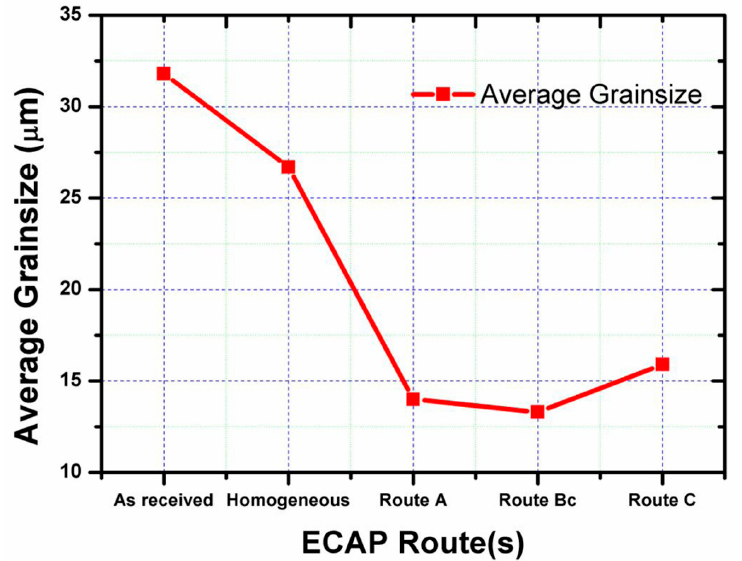
Figure 5. Average grain size depending on the routes [49].